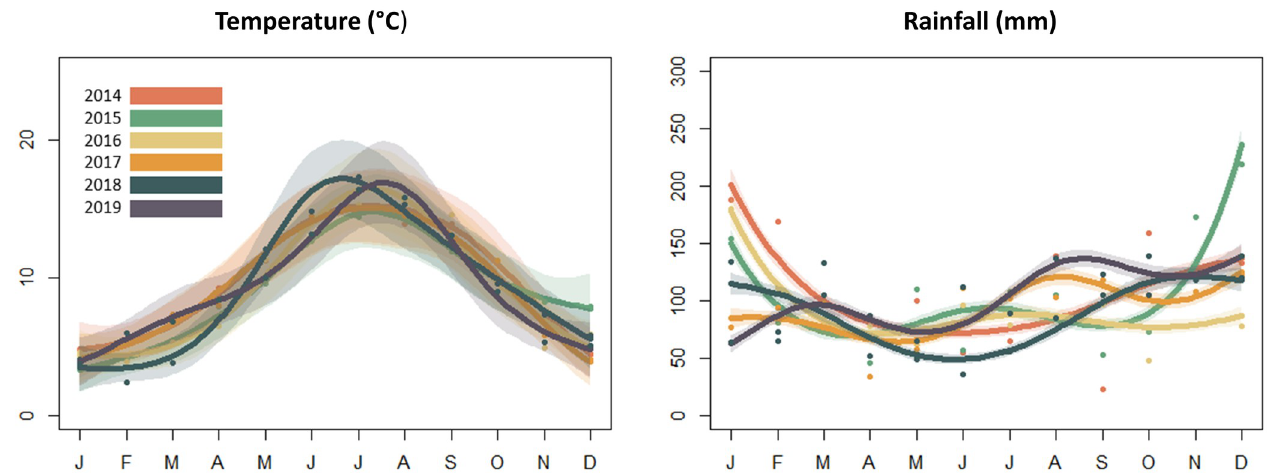
Fig 1. Variations in temperature and rainfall. Smoothed plots showing variation in mean temperature and rainfall across the UK during the six years that we report roadkill data from; 2014–2019.